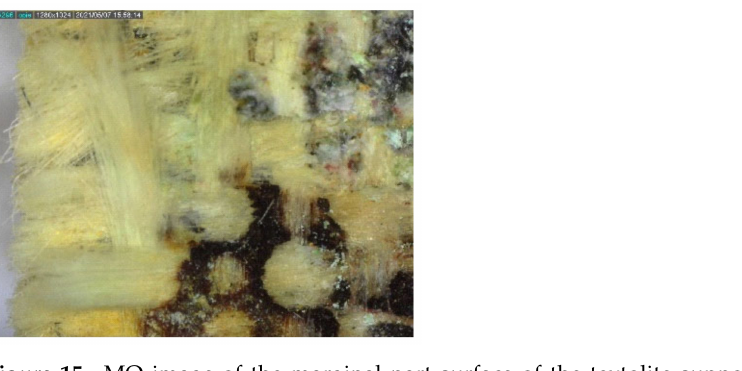
Figure 15. MO image of the marginal part surface of the textolite support, which was heavily degraded (40 times magnification). In the immediate vicinity of the edge, the resin had been almost completely burned out; the exposed textile support is visible.